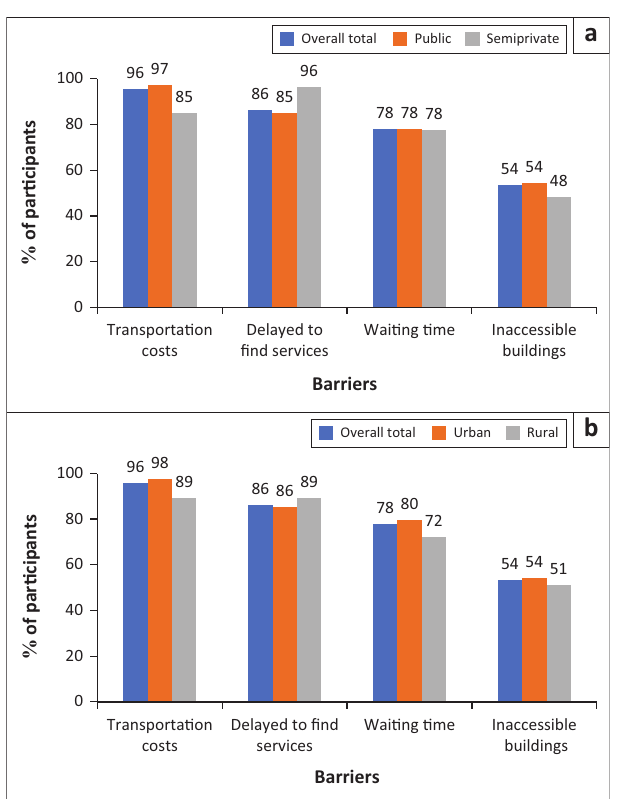
FIGURE 3: (a) Barriers to rehabilitation use by facility funding source where participants were recruited (public: n = 186, semiprivate: n : 27; (b) Barriers to rehabilitation use by participants’ residence (urban: n = 166, rural: n =